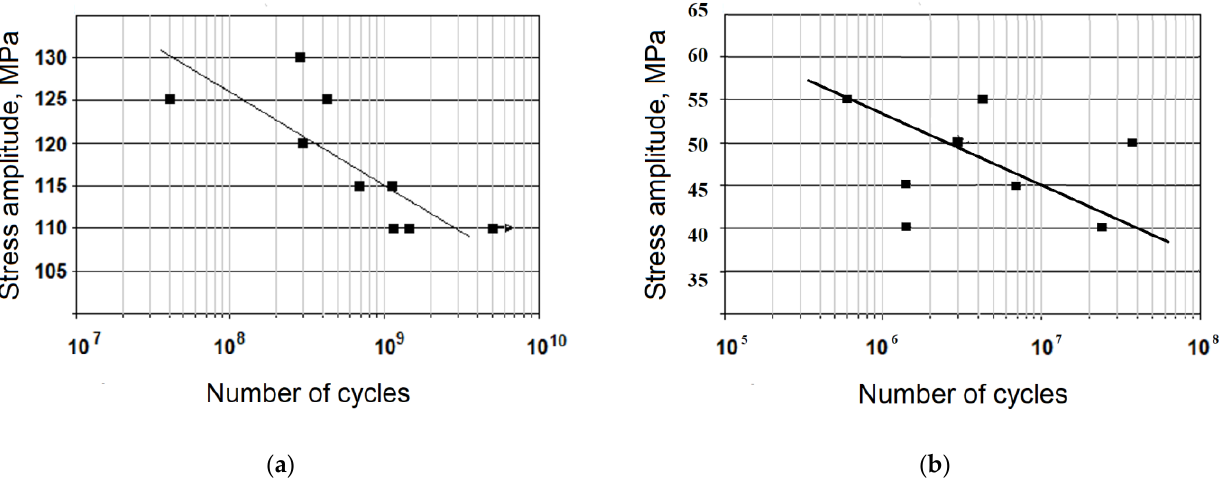
Figure 7. The SN-curves for hot-rolled ( a ) and SLM specimens ( b ).